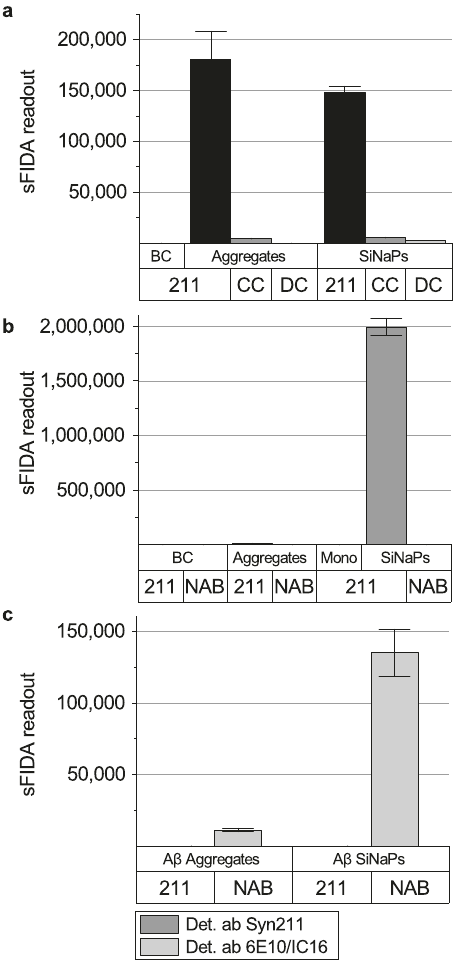
Fig. 4 sFIDA with antibodies against α -synuclein speci fi cally detects α -synuclein aggregates and α -synuclein SiNaPs but not α -synuclein monomers, A β aggregates, or A β SiNaPs. a When either the capture antibody or the detection antibodies were omitted (capture control (CC), detection control (DC)), the sFIDA readout for the CC was reduced by 96% for α -synuclein SiNaPs and 97% for α -synuclein aggregates of the respective readout with a capture antibody. For the DC, the sFIDA readout was reduced by 98% for α -synuclein SiNaPs, and entirely for α -synuclein aggregates (100%), where the sFIDA readout was indistinguishable from the buffer control (BC). b The sFIDA readout of α -synuclein SiNaPs and α - synuclein aggregates, when captured with the NAB228 antibody against beta-amyloid (A β ), was reduced by almost 100% for α - synuclein SiNaPs and 98% for synthetic α -synuclein aggregates compared to the signal with Syn211 capture antibody. The sFIDA readout of α -synuclein monomers (Mono) was reduced to the level of the BC compared to the same concentration of monomers in aggregated α -synuclein. c Additionally, A β aggregates and A β SiNaPs were captured and detected with the Syn211 antibody against α - synuclein. As a positive control, the same A β aggregates and A β SiNaPs were captured with antibodies speci fi c to A β (capture antibody: NAB228, detection antibodies: 6E10/IC16). The graph shows that the Syn211 antibody does not detect A β aggregates or A β SiNaPs. Error bars indicate standard